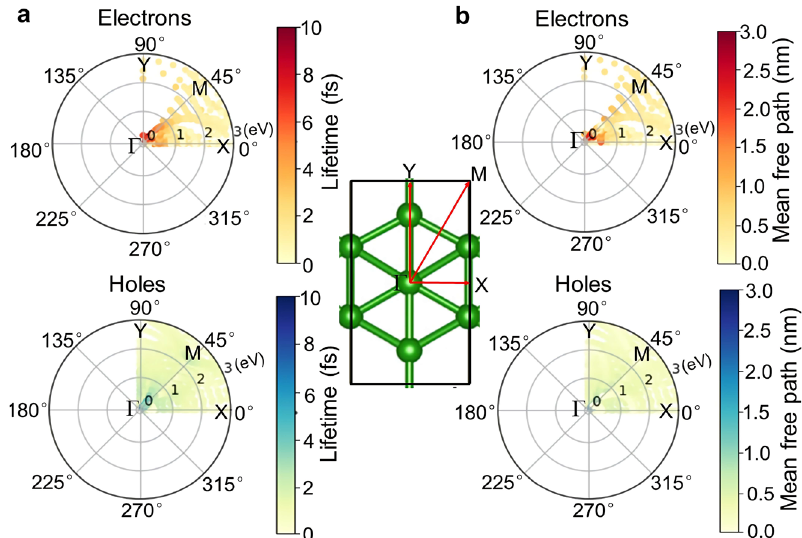
Figure 9: Lifetimes (a) and mean free paths (b) of photon/plasmon-driven hot